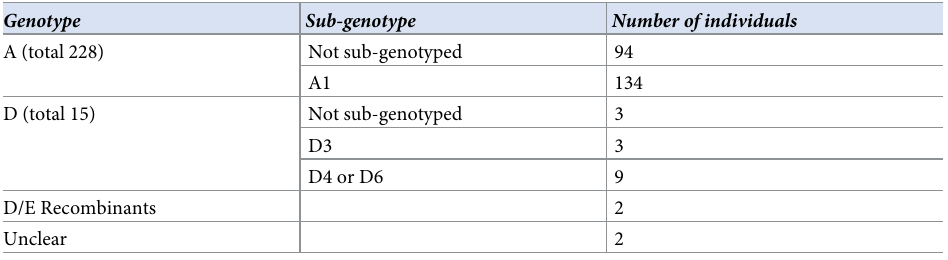
Table 3. Numbers of individuals in which HBV genotype or sub-genotype was reported for study populations in Kenya, as part of a systematic review for HBV in Kenya from 2000–2021. Data from 8 studies marked � in Table